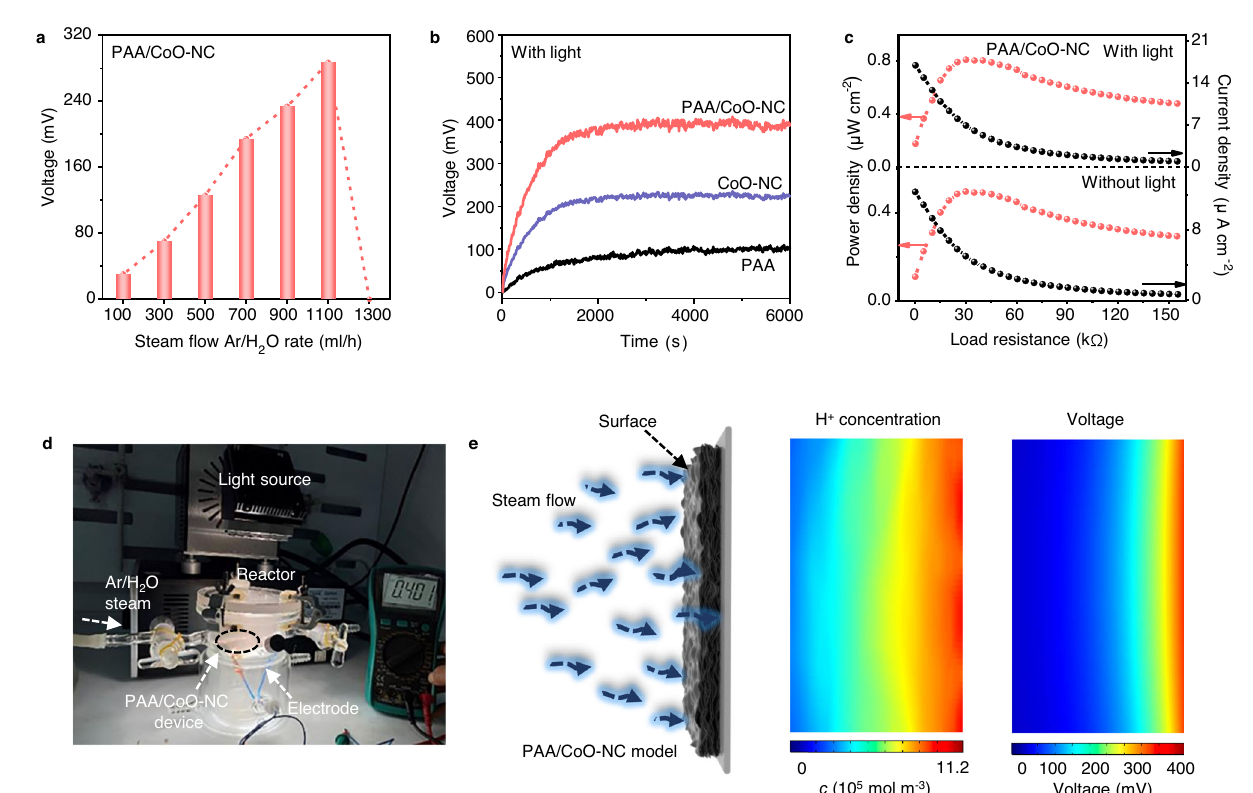
Fig.2|Hydrovoltaicvoltagegenerationandfactorstuningofthehydrovoltaic effect-enhanced photocatalysis system. a Measured output voltage of PAA/ CoO – NC under different Ar/H 2 O fl ow rates; b Measured output voltage for CoO – NC, PAA and PAA/CoO – NC over time with light illumination (light intensity: AM 1.5G; 100mWcm − 2 ); c Output power and current density of PAA/CoO – NC under different load resistances with or without light illumination. Red arrow